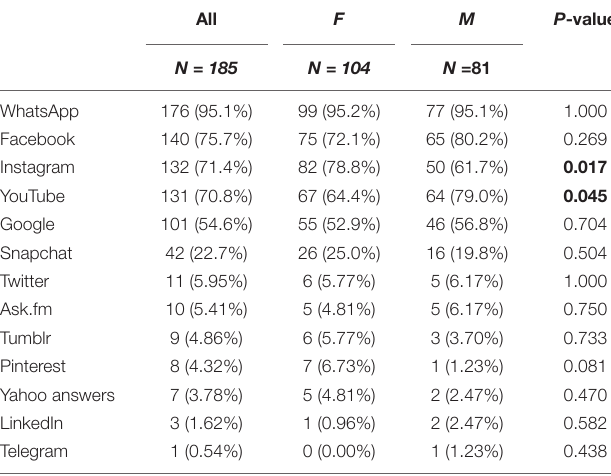
TABLE 3 | Use of different social media platforms in the overall sample and by